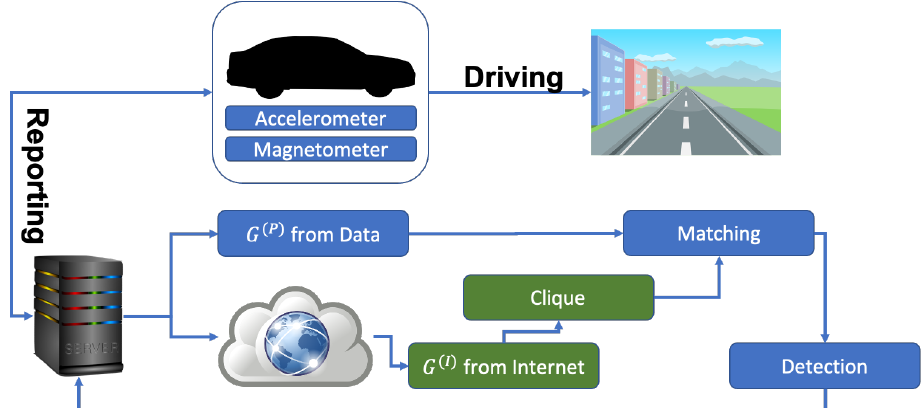
Figure 3. Overarching schema of our proposal. Sensors read data from the car movement, which are reported to a central server. Here we create the two graphs, G ( P ) and G ( I ) , and from the latter we find all the possible subgraphs of any size. We then perform the matching between G ( P ) and the subgraphs we found, eventually detecting the best possible match and reporting it back. We note that the G ( I ) download and the clique operation can be performed in advance, and stored in memory, to save time for the matching